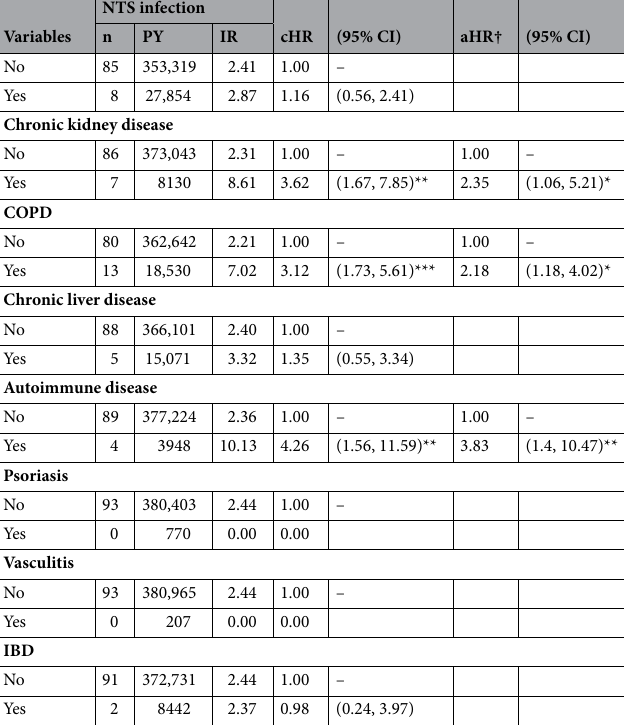
Table 2. Incidence Rate and Hazard Ratio of NTS Infection. NTS nontyphoidal salmonella, COPD chronic obstructive pulmonary disease, IBD Inflammatory bowel disease, PY person-year, IR incidence rate per 10,000 person-year, cHR crude hazard ratio, aHR adjusted hazard ratio. † Adjusted by age, hypertension, diabetes, coronary artery disease, chronic kidney disease, COPD and rheumatoid autoimmune disease. * p value < 0.05; ** p value < 0.01; *** p value <